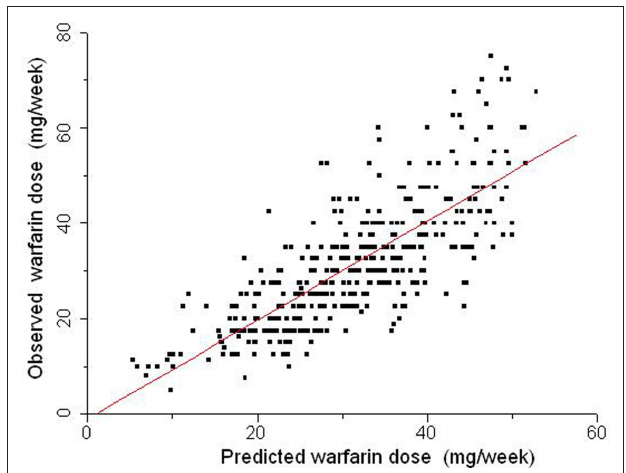
FIgure 5 | relationship between warfarin weekly doses predicted by a multiple regression model (abscissa) and the stable doses actually taken by 390 patients (ordinate) from INCL, rio de Janeiro. The covariates in the dosing algorithm were age, weight, treatment indication, co-medication with amiodarone or simvastatin, VKORC1, and CYP2C9 genotypes and the first available INR reading for each patient. The identity line is traced. Data from Suarez-Kurtz et al.